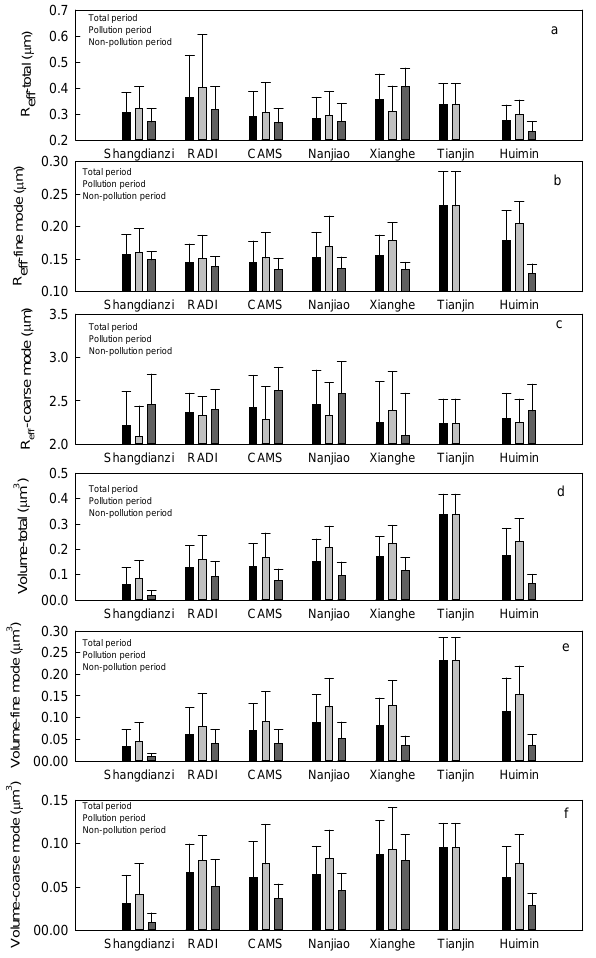
Fig. 7. Means of aerosol size distribution properties during the total period (January 2013), pollution period (daily PM 2 . 5 ≥ 75µgm − 3 ) , and non-pollution period (daily PM 2 . 5 ≤ 75µgm − 3 ) at each site. (a) Retrieved effective radius of total mode; (b) retrieved effective radius of fine mode; (c) retrieved effective radius of coarse mode; (d) retrieved aerosol particle volume of total mode; (e) retrieved aerosol particle volume of fine mode; and (f) retrieved aerosol par- ticle volume of coarse